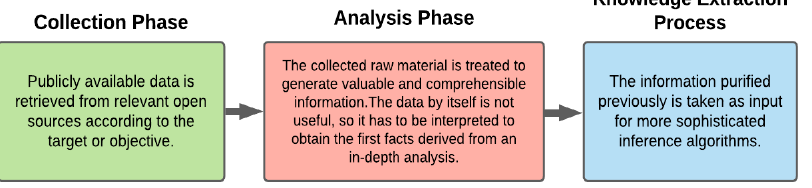
Figure 1. OSINT Phases [19,20], sequential phases for open-source information processing. The objective of this process is to generate knowledge from the data